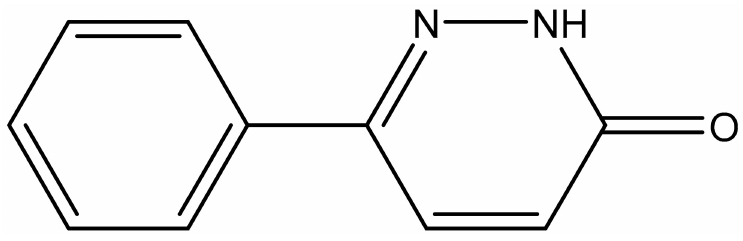
Figure 1. Chemical structure of